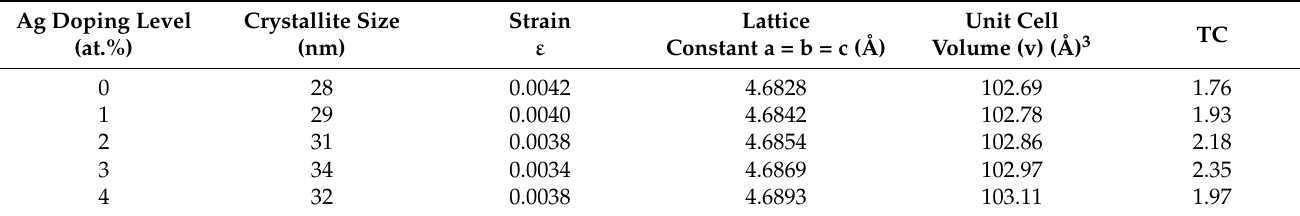
Table 1. Structural properties of Cd 1_ x Ag x O thin